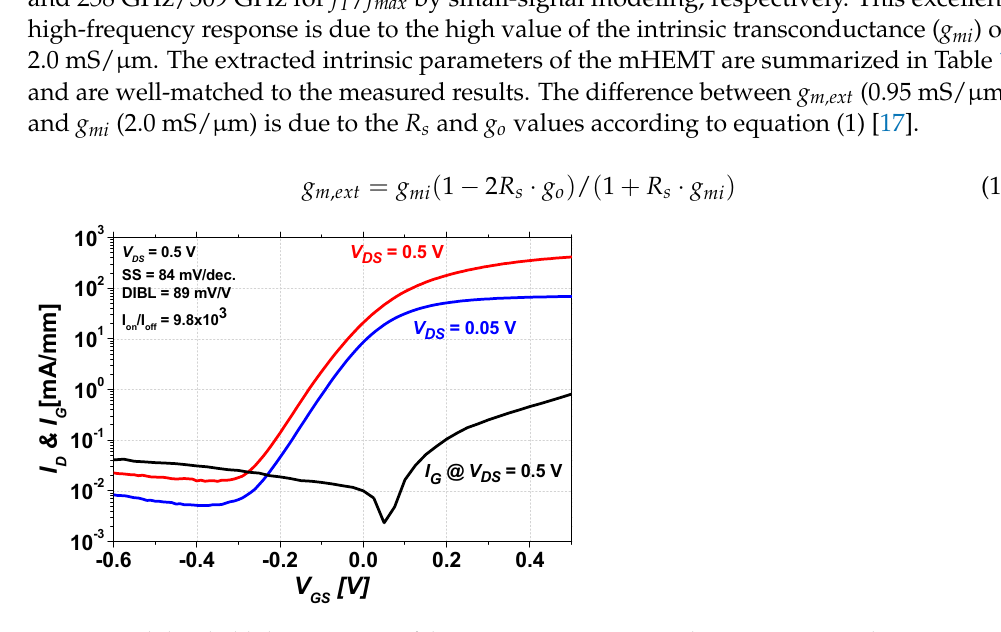
Figure 3. Subthreshold characteristics of the mHEMT were measured at V DS = 0.5 V and V DS = 0.05 V, and the gate leakage current was measured at V DS = 0.5 V, respectively.